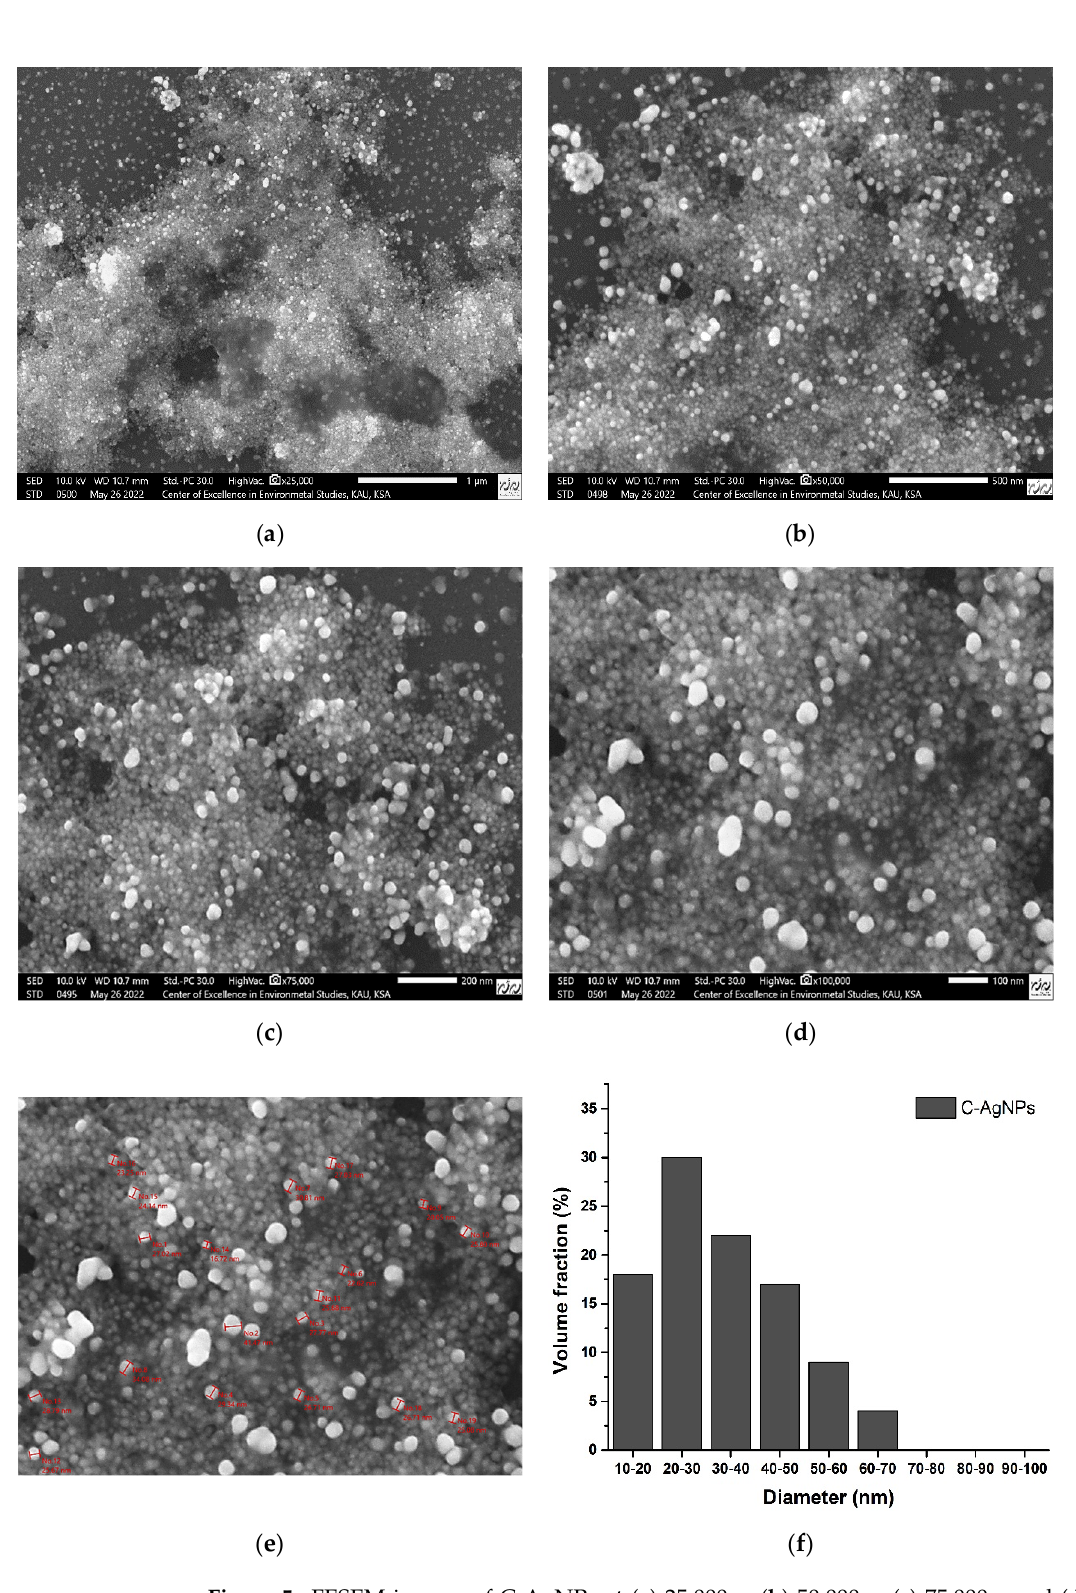
Figure 5. FESEM images of C-AgNPs at ( a ) 25,000×, ( b ) 50,000×, ( c ) 75,000× and ( d ) 100,000× magnification, ( e ) C-AgNPs size determination by adding scale bar on them, and ( f ) particle size distribution analysis.